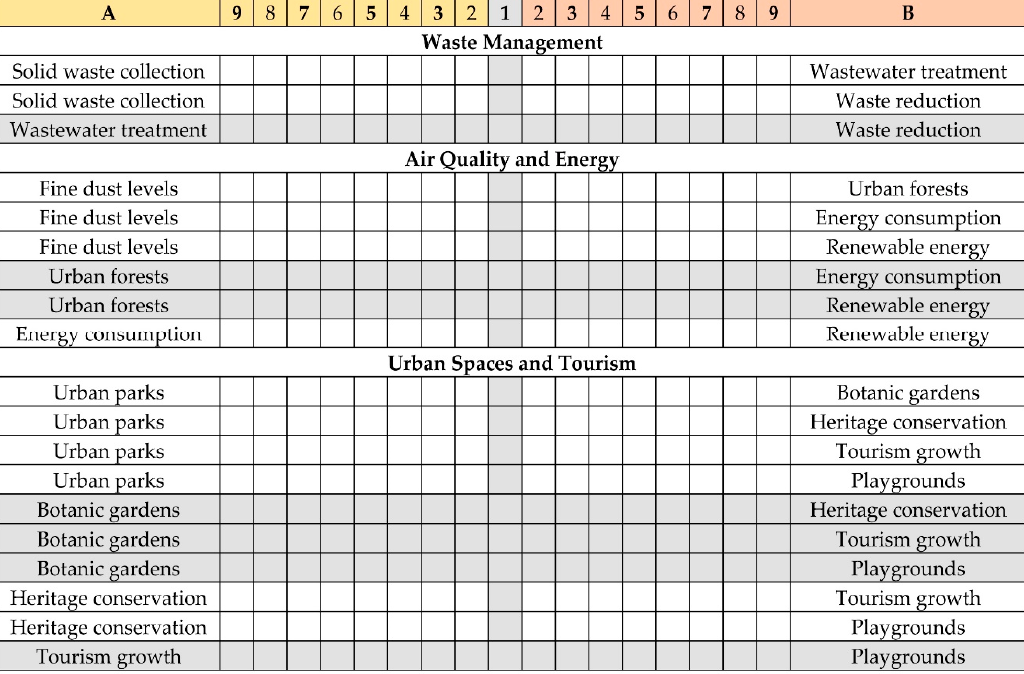
Figure A4. AHP questionnaire for prioritizing assessment indicators of Waste Management, Air Quality and Energy, and Urban Spaces and Tourism. Note: 1 = Equal importance, 3 = Moderate importance, 5 = Strong importance, 7 = Very strong importance, 9 = Extreme importance (2,4,6,8 ‐ Values in ‐ between).